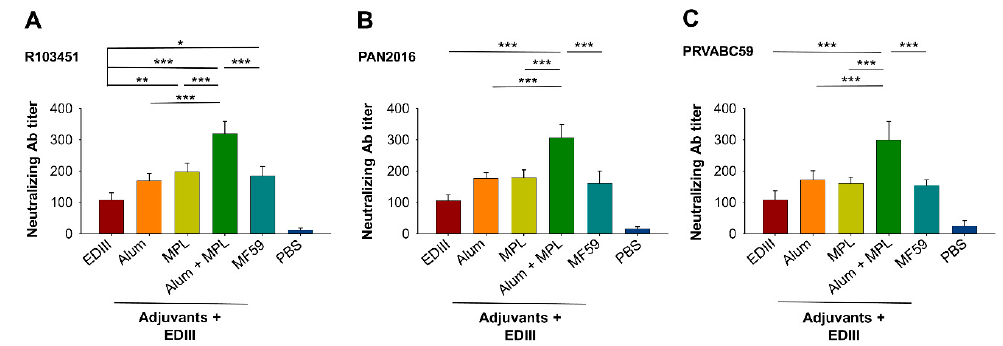
Figure 3. Detection of neutralizing antibody titers in immunized mouse sera. Sera collected at seven days following the second dose of EDIII were tested by a plaque reduction neutralization test (PRNT) assay for neutralizing antibodies against ZIKV human strains R103451 ( A ), PAN2016 ( B ), and PRVABC59 ( C ). PBS shows the background level of neutralizing antibodies. Neutralizing activity for the indicated adjuvants is presented as the neutralizing antibody titer based on the serum neutralizations at a 50% plaque reduction (PRNT 50 ). Data are expressed as the mean ± s.e.m ( n = 5). Significant differences (*: p < 0.05; **: p < 0.01; ***: p < 0.001) among different groups are shown.